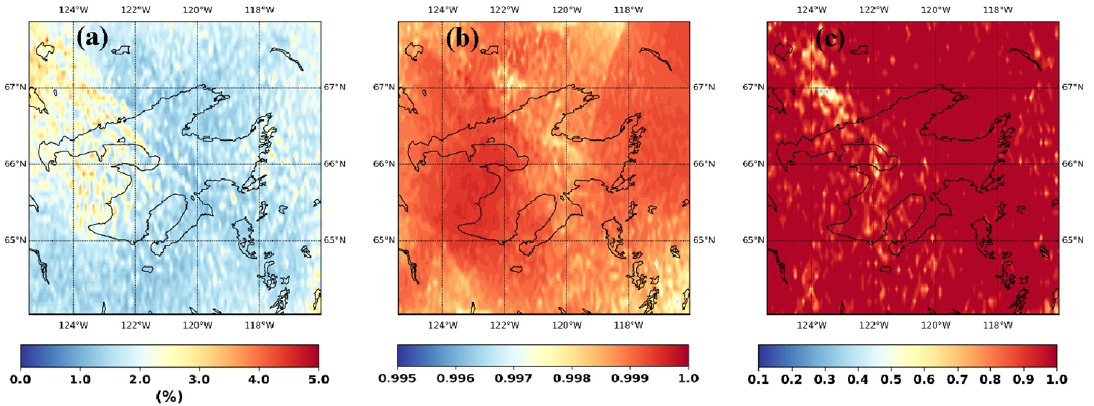
Figure 8. Performance of the downscaling ( a ) mean absolute percentage error, ( b ) temporal correlation, and ( c ) P-value for Kolmogorov-Smirnov test of temporal distribution equivalency.